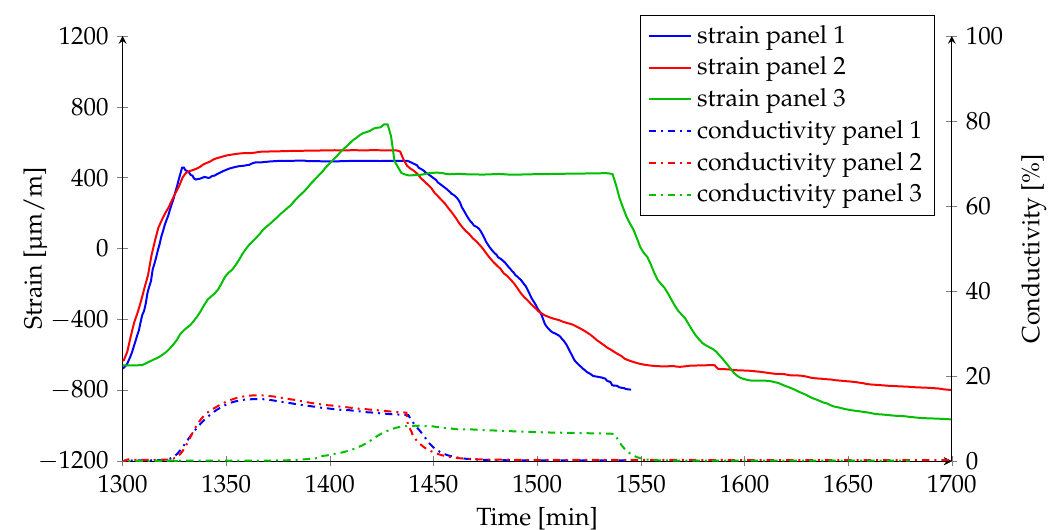
Figure 7. Measured strain and conductivity of the post-curing step of panels 1, 2 and